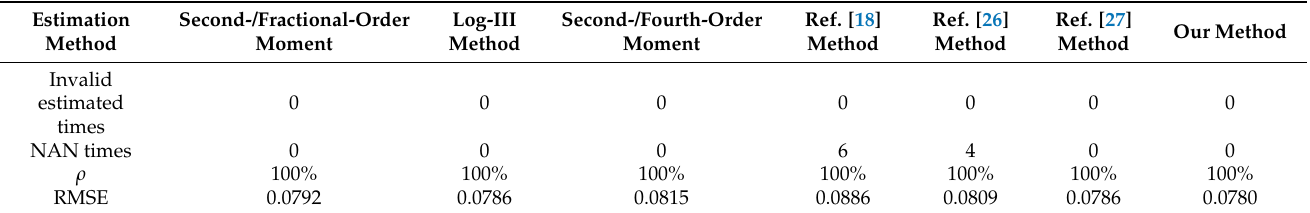
Figure 5. Partial IPIX sea clutter 2D map of HH polarization. The estimated effective rate ρ is shown in Table 3. Table 3. The statistics of estimation efficiency and estimation accuracy in measured K-distribution ( k = 0.5).